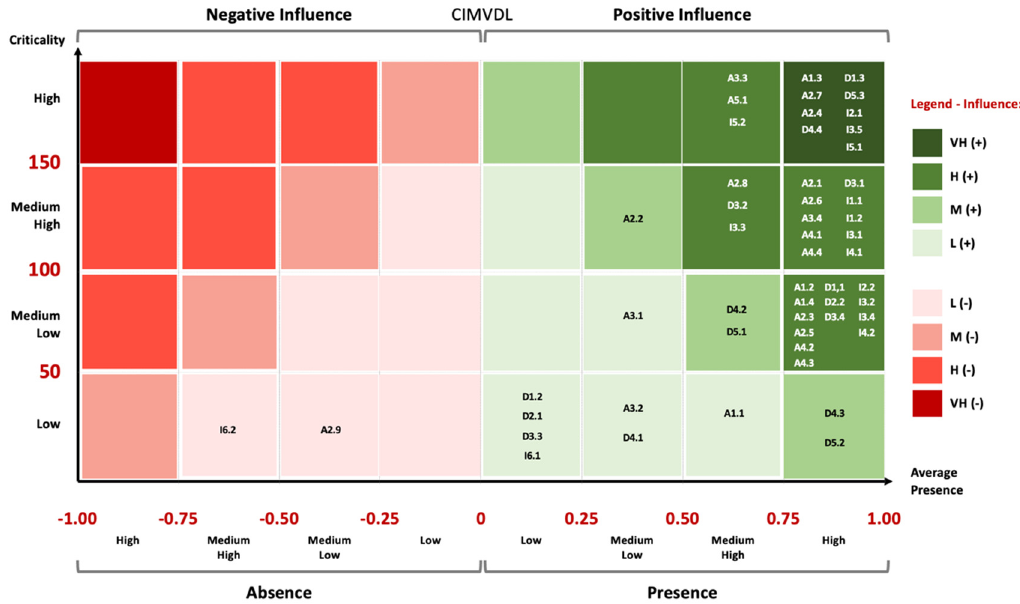
Figure 11. Matrix of Influence with 53 Categories (CIMVDL) . Source: the authors.